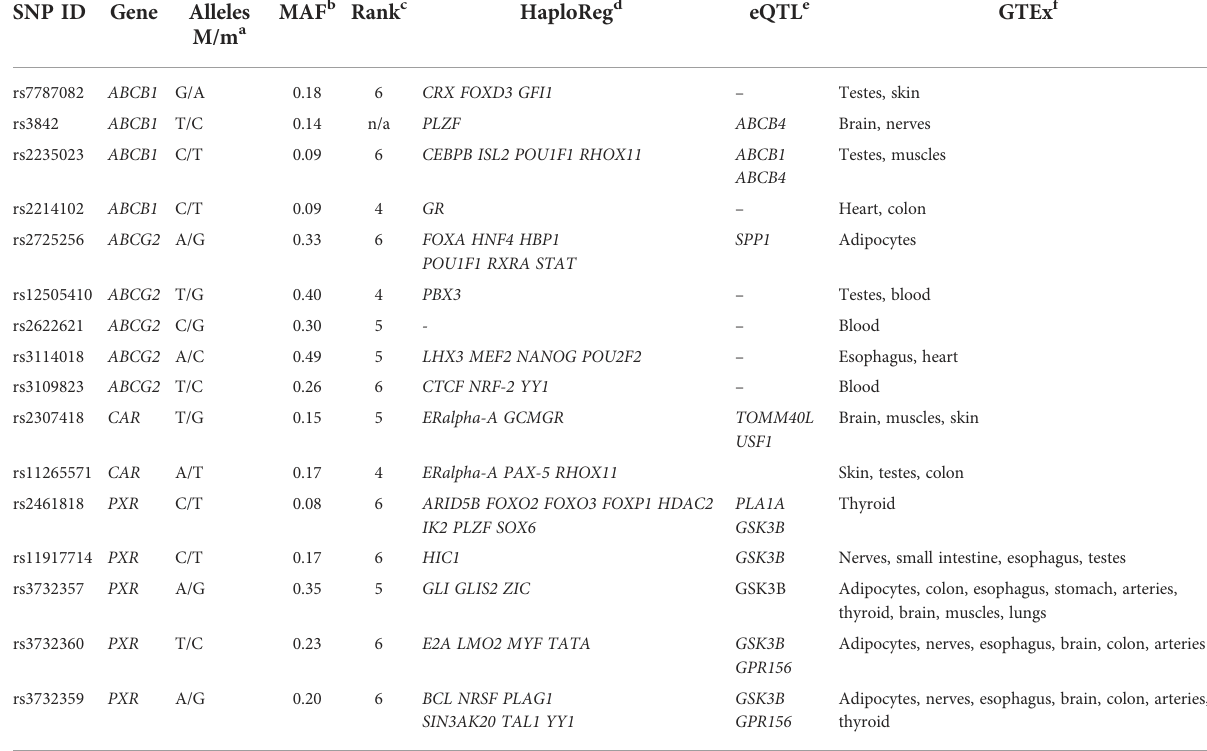
TABLE 4 Summary of bioinformatic SNP